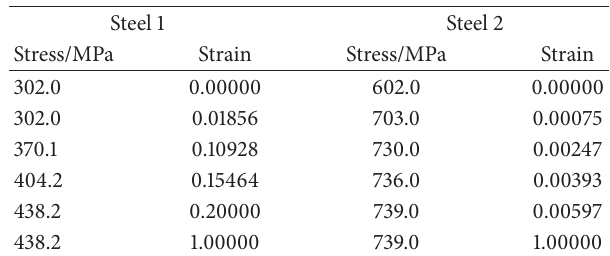
Figure 1: Local buckling of the bolted steel plates in (a) RC beams and (b) columns strengthened using the steel jacketing technique. Table 1: Constitutive relation of